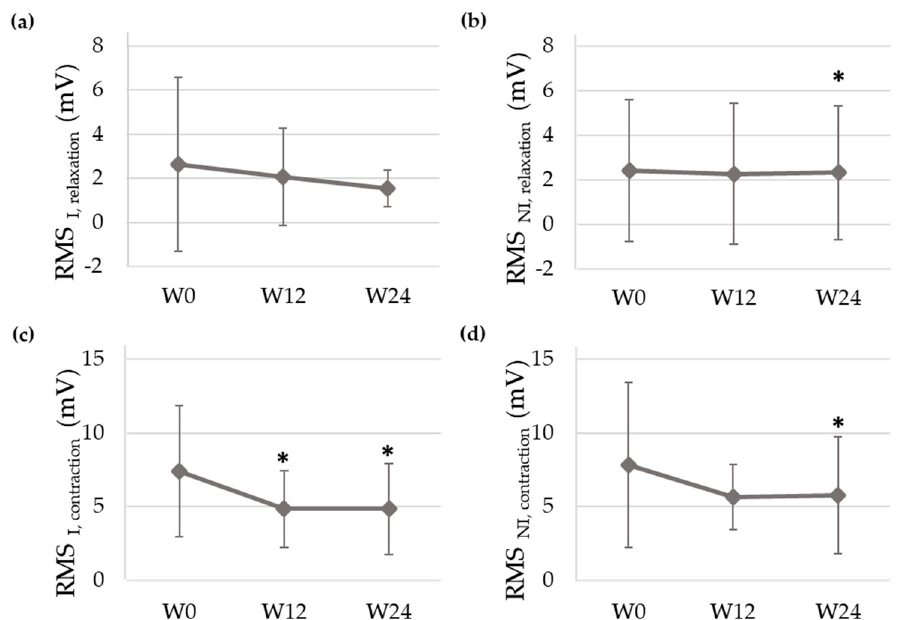
Figure 5. Mean and standard deviation of the root mean square (RMS) of the surface electromyo- graphic signal of the pelvic floor muscles’ infiltrated (I) and non-infiltrated (I) sides during relaxations (( a , b ), respectively) and contractions (( c , d ), respectively) at Weeks 0 (W0), 12 (W12) and 24 (W24) of the study. (*): p value (Test 1) < 0.05.